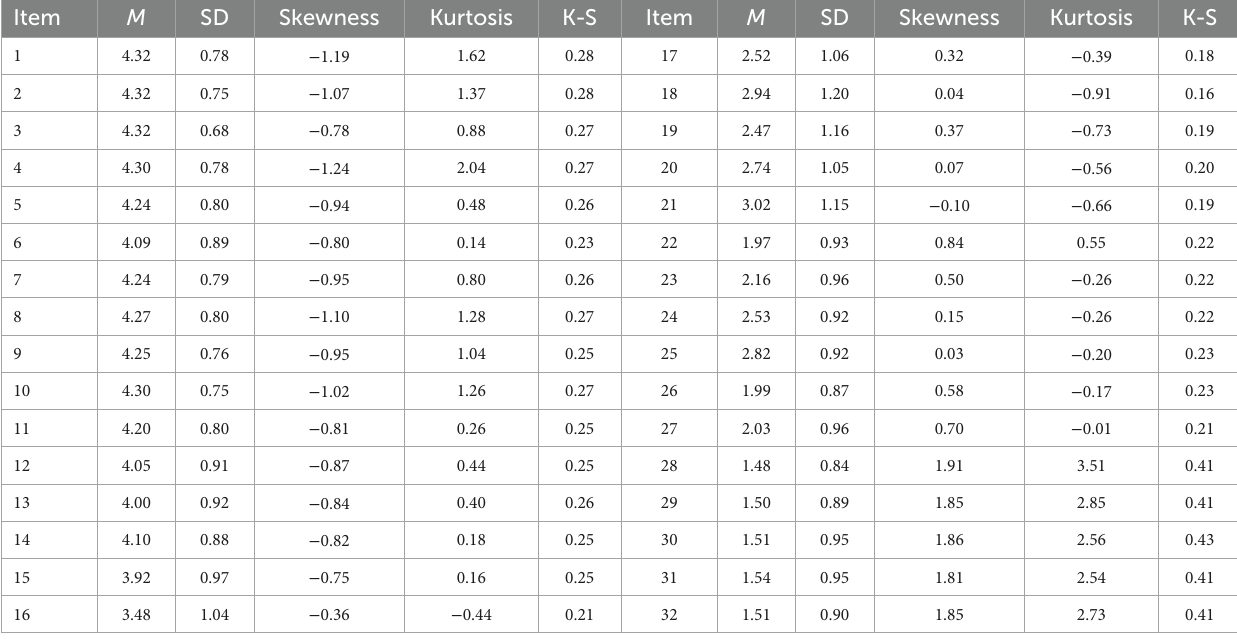
TABLE 2 Descriptive and distribution analysis of the items ( N =